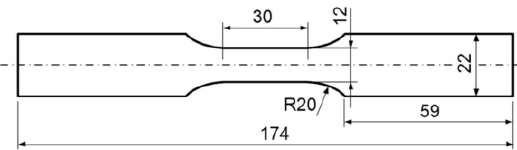
Figure 1. Flat specimens for tensile and low-cycle fatigue experiments on the AZ31 alloy; (measurement unit is mm).